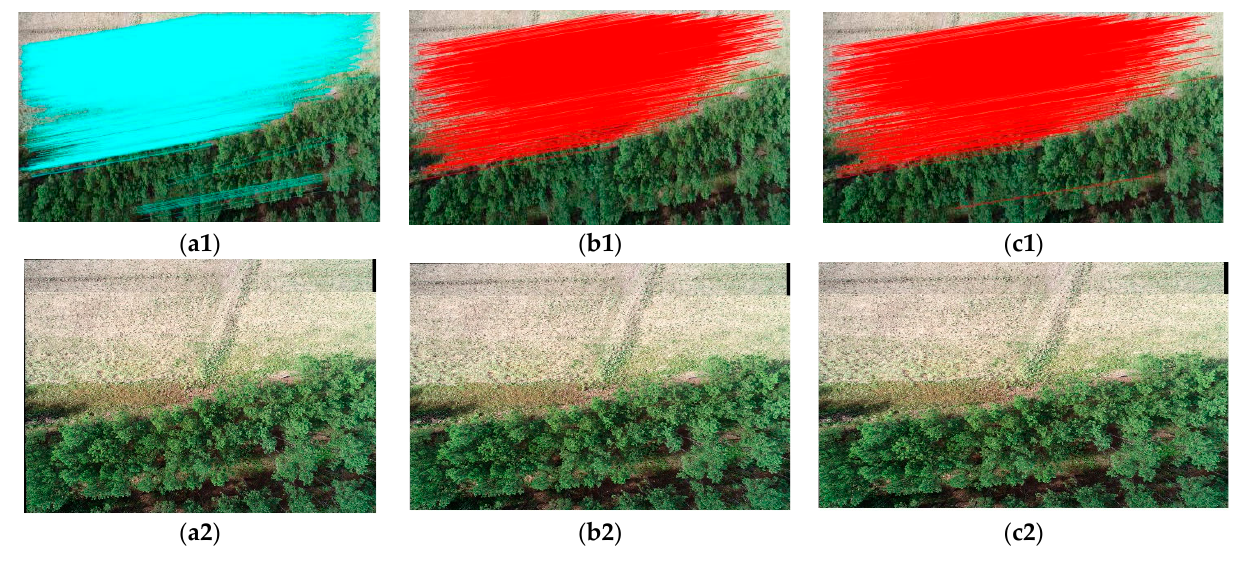
Figure 4. Feature matching and splicing effects on linear features in the forest edge area. ( a1 ) Feature matching results of the SIFT algorithm. ( a2 ) Splicing effect of the SIFT algorithm. ( b1 ) Feature matching results of the SIFT-OCT algorithm. ( b2 ) Splicing effect of the SIFT-OCT algorithm. ( c1 ) Feature matching results of the optimized SIFT-OCT algorithm. ( c2 ) Splicing effect of the optimized SIFT-OCT algorithm.